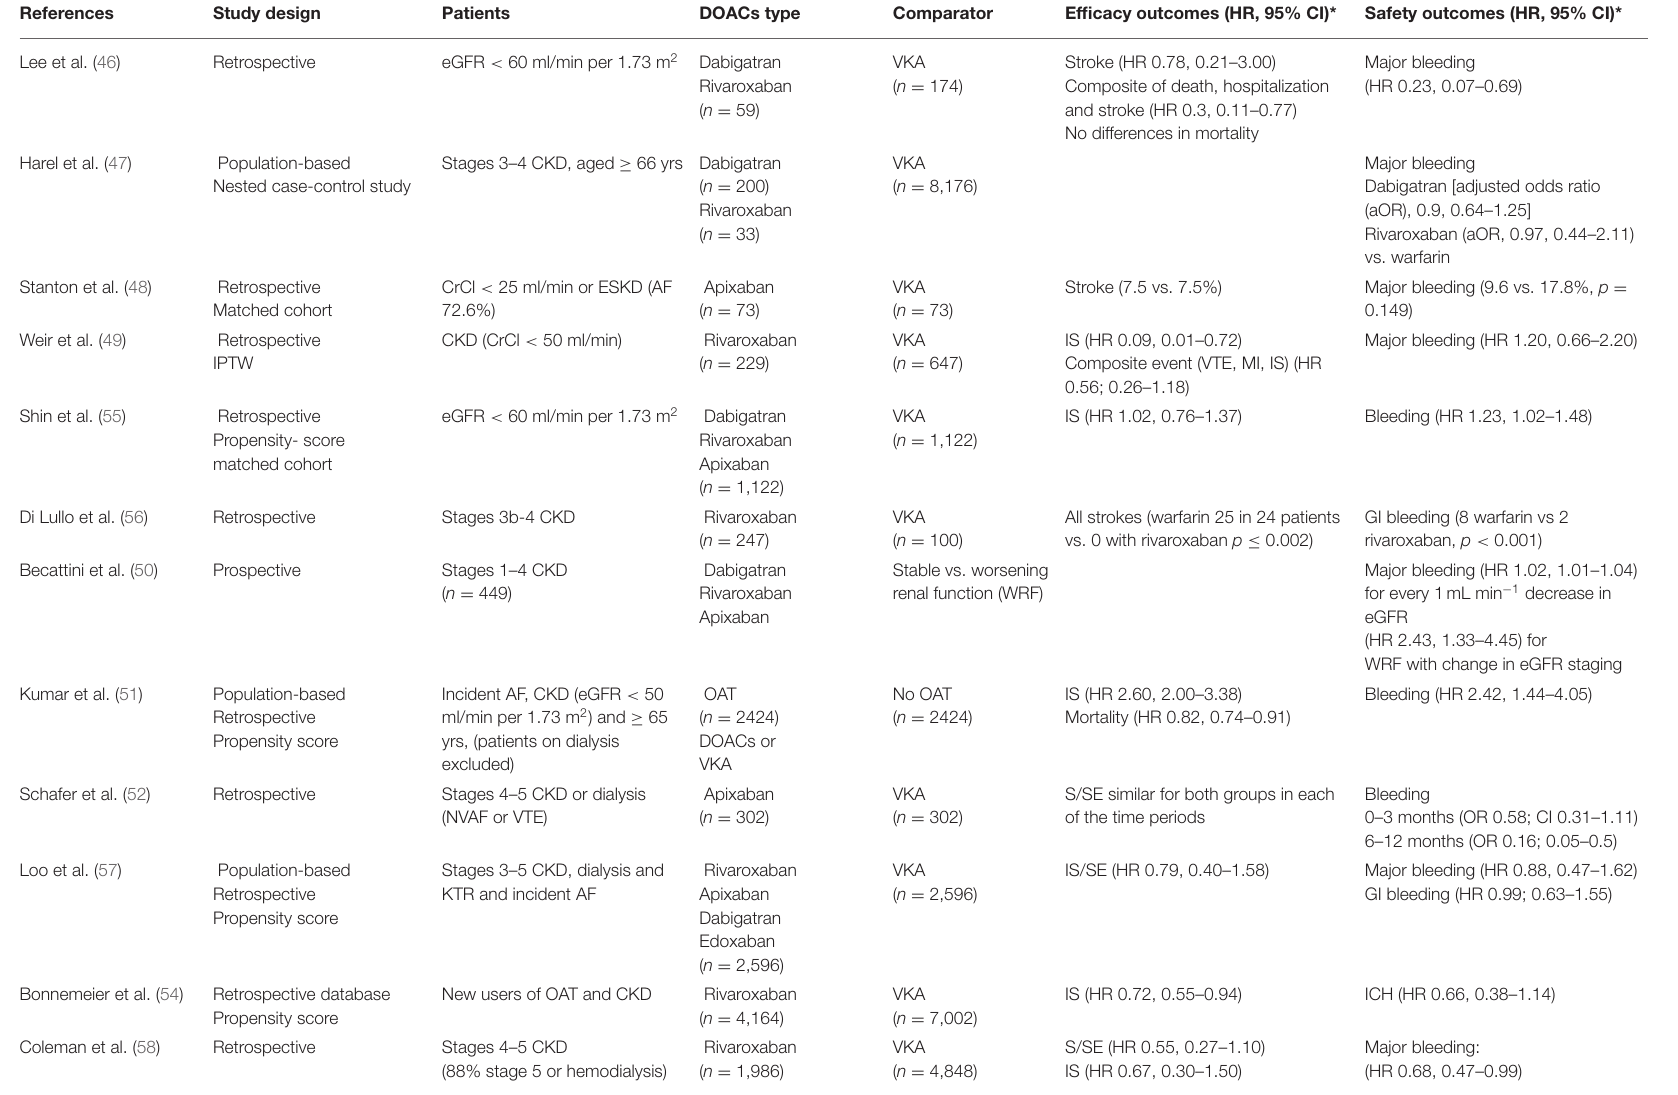
TABLE 2 | Observational studies comparing DOACs vs. VKA or no anticoagulation in CKD